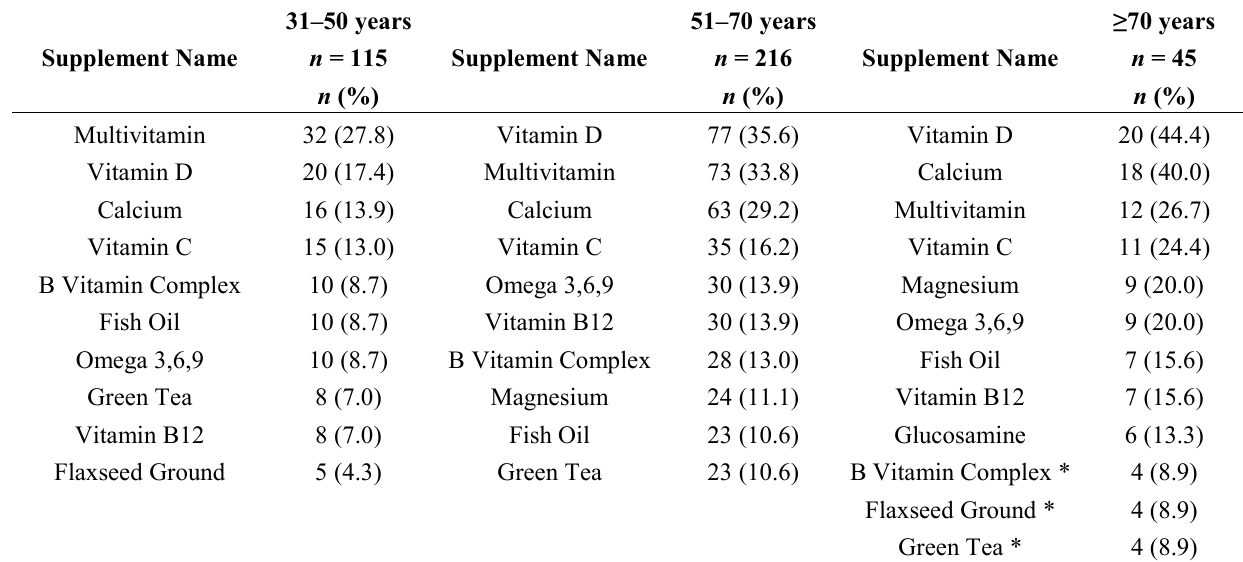
Table 5. 10 Most Frequently Used Supplements by